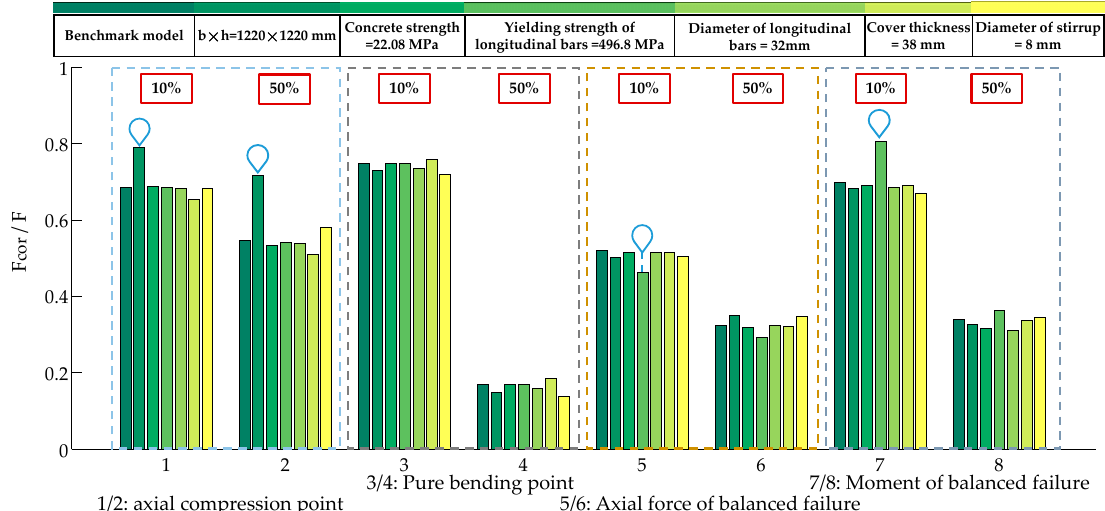
Figure 9. Calculated values of basis points under different parameter combinations.